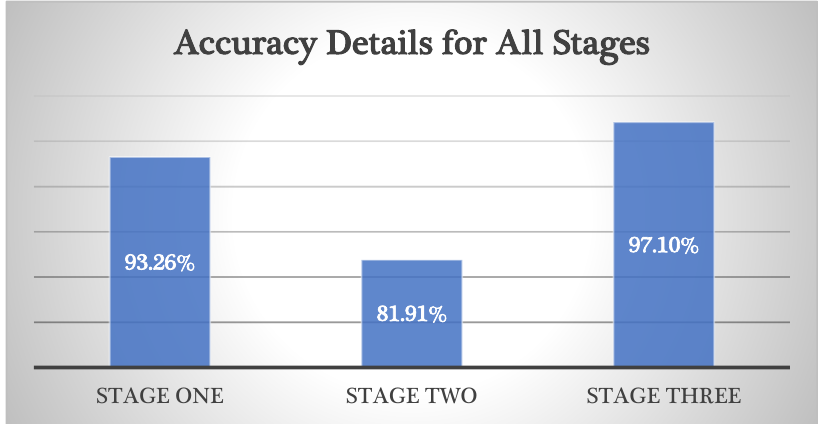
Figure 6. Accuracy in detection when using different algorithms.